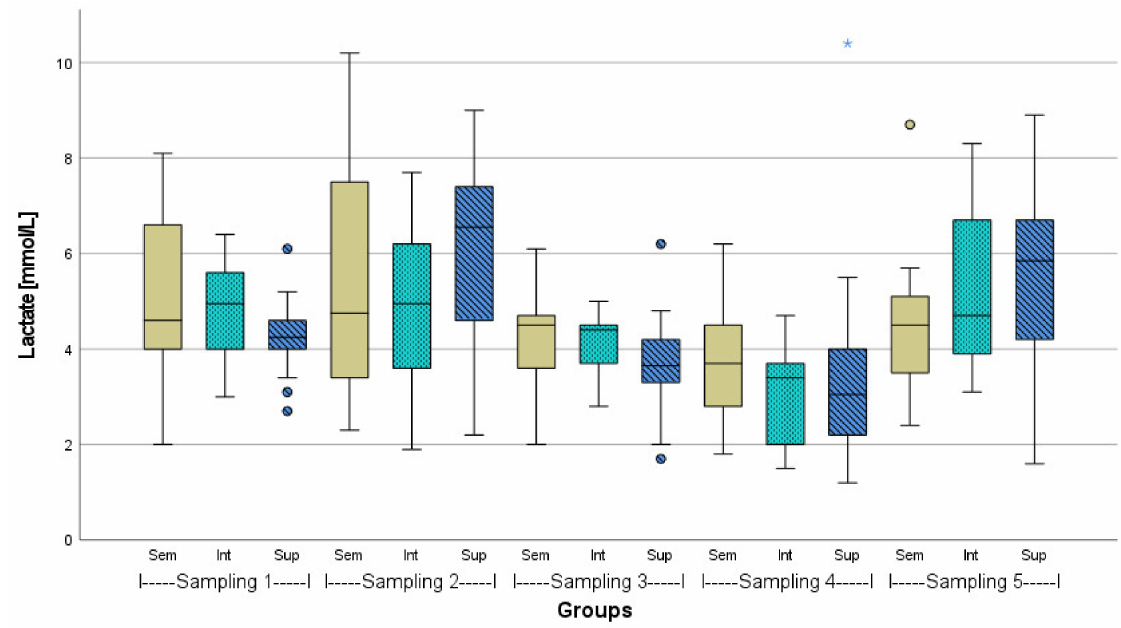
Figure 2. Lactate level of African catfish ( n = 18) in three different stocking densities (Sem = semi-intensive, Int = intensive, Sup = super-intensive), p > 0.05. Circlets = outliers; asterisk = extreme